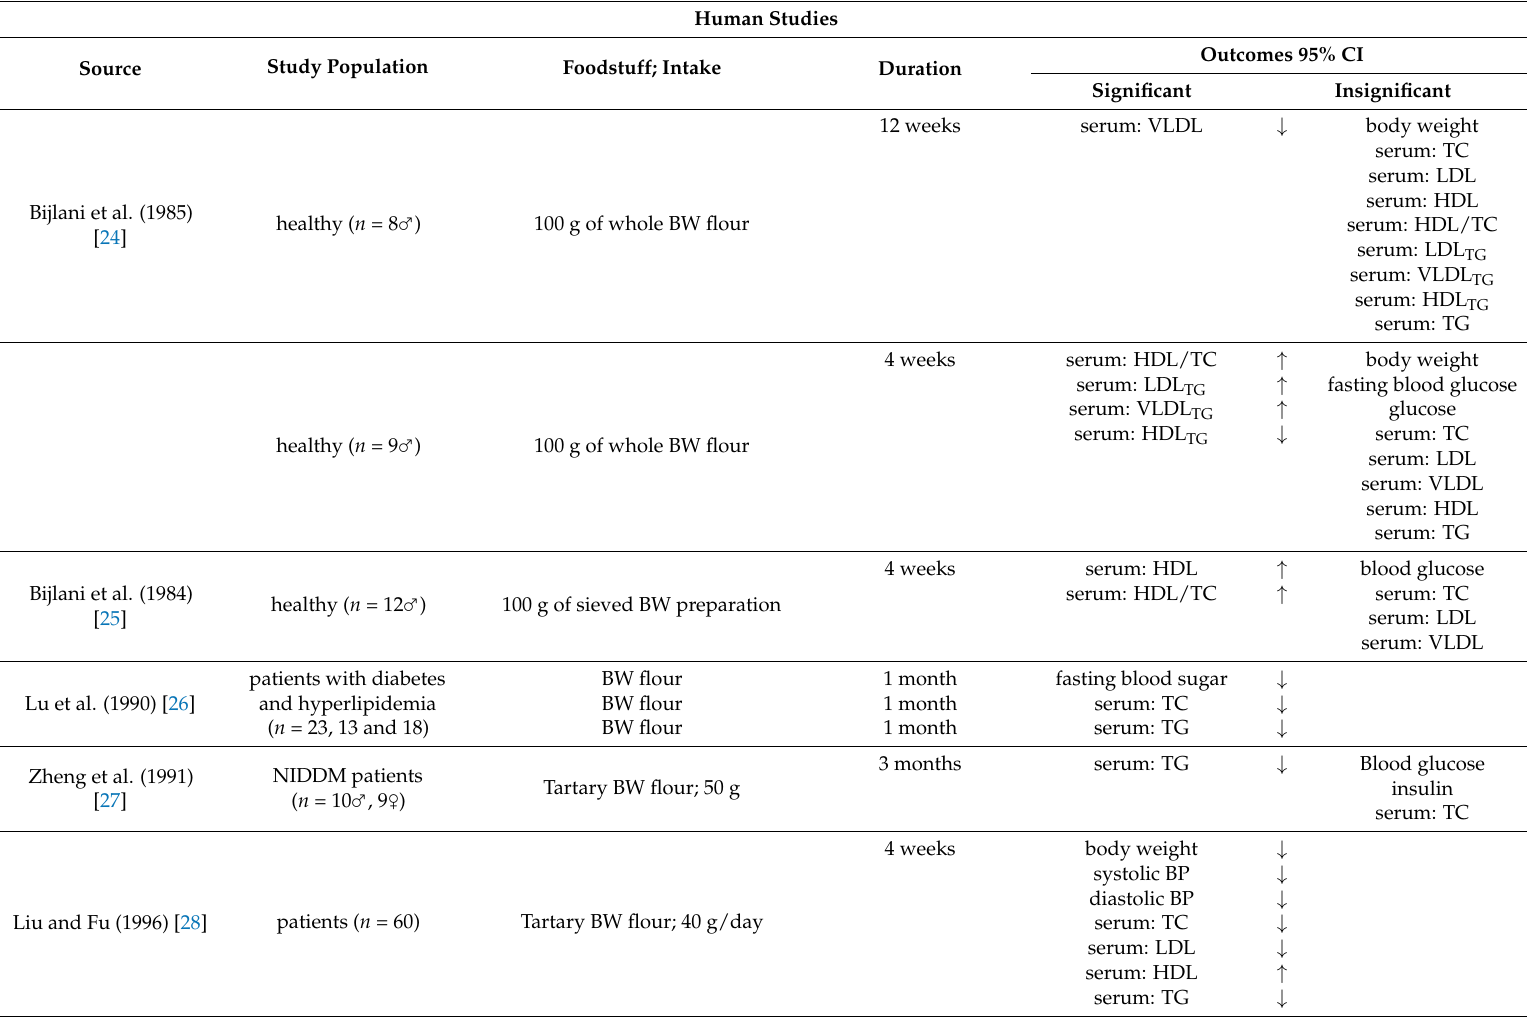
Table 1. Summary of all human studies